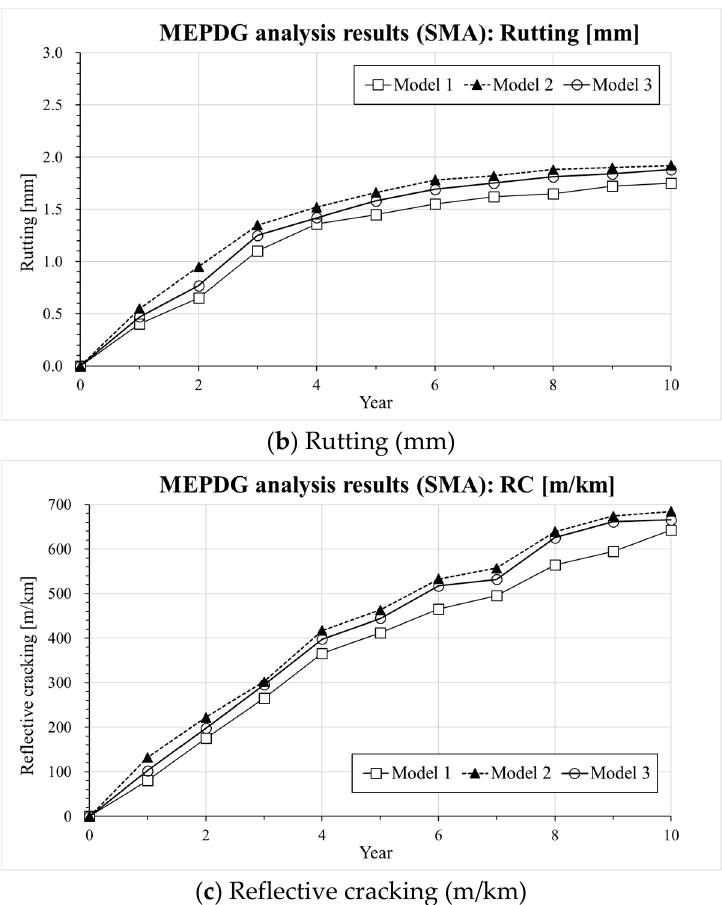
Figure 6. Results of AASHTOWARE analysis for Mixture 2 (SMA): ( a ) IRI, ( b ) Rutting, ( c ) Reflective cracking.